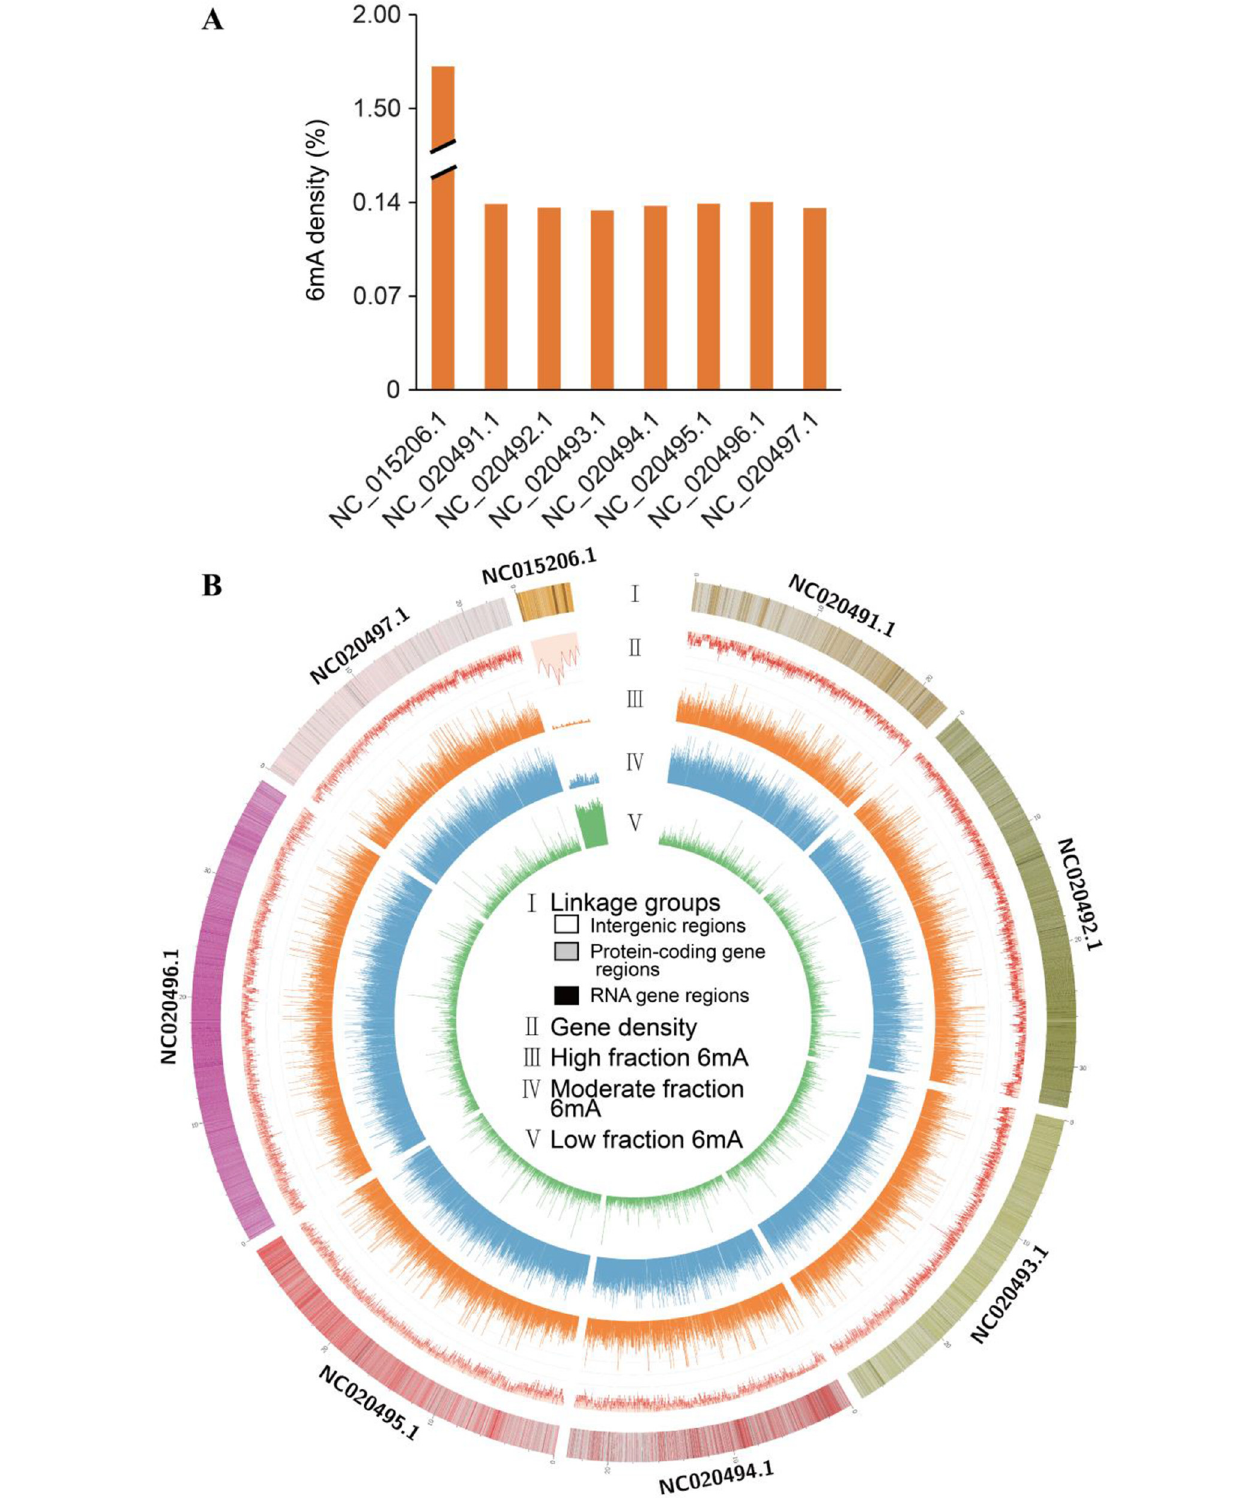
FIGURE 1 | Distribution of N 6 -methyladenine ( 6mA ) in Fragaria vesca v1.0 genome. (A) Density of 6mA modi fi cation of F. vesca linkage groups. (B) Circos plot of 6mA in the F. vesca genome. I : The seven linkage groups and chloroplast complete genome (NC_015206.1); light color represents intergenic regions; ashen color represents protein-coding gene regions; dark color represents RNA gene regions. II : Gene density. III : High 6mA methylation (65 – 100%). IV : Moderate 6mA methylation (35 – 65%). V : Sparse 6mA methylation (0 – 35%).